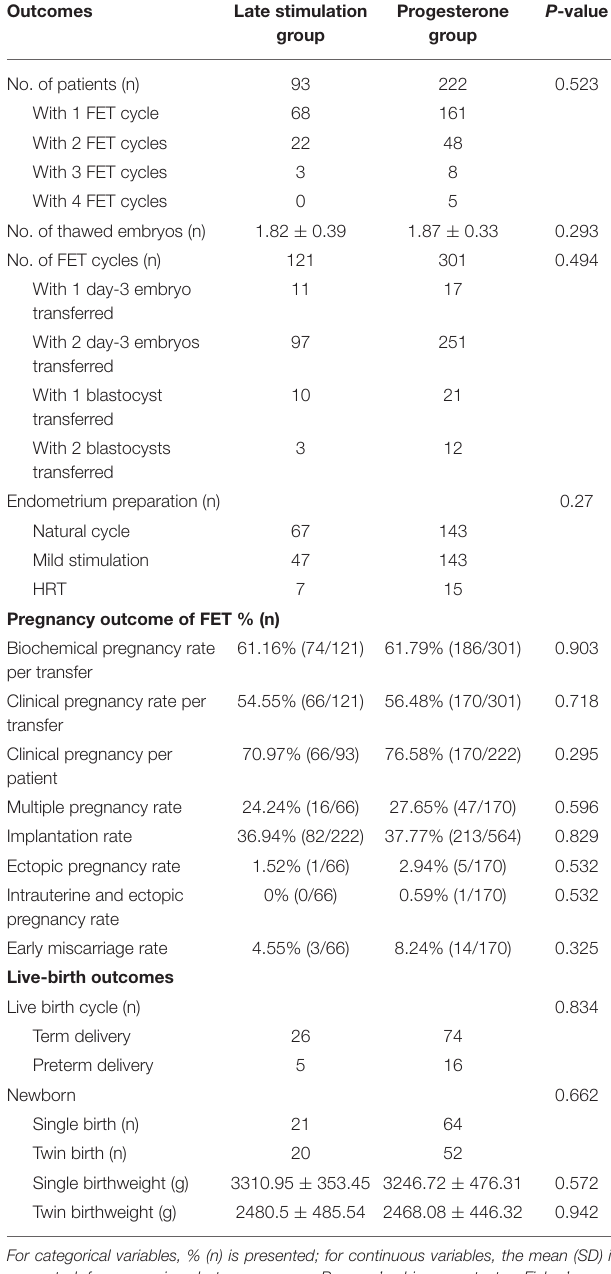
TABLE 2 | Ovarian stimulation characteristics and embryo results of controlled ovarian stimulation in the two regimens. Characteristics